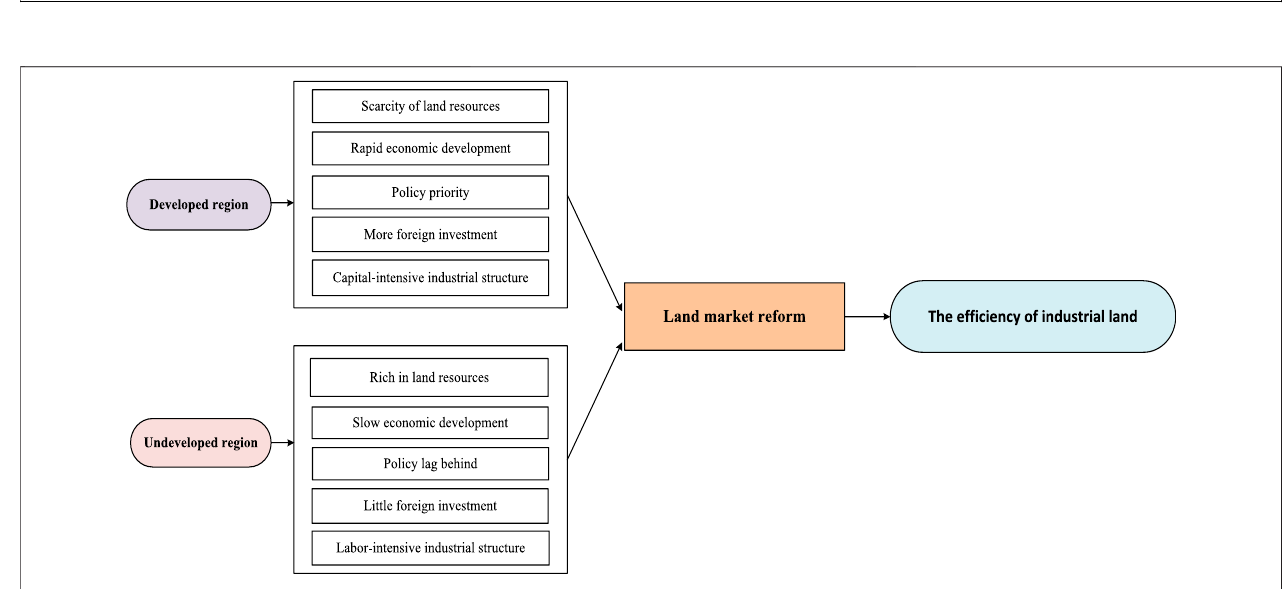
FIGURE 1 | Theoretical framework of impact of marketization process on the ILUE.